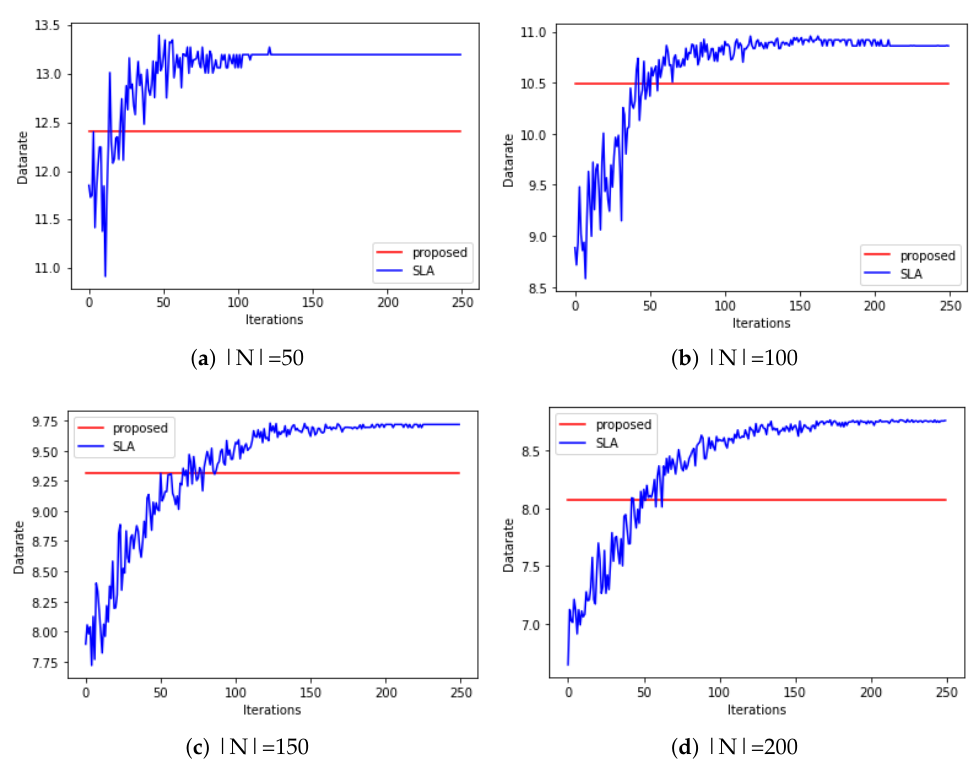
Figure 10. Comparison with the SLA in terms of the average data rate of the coexisting